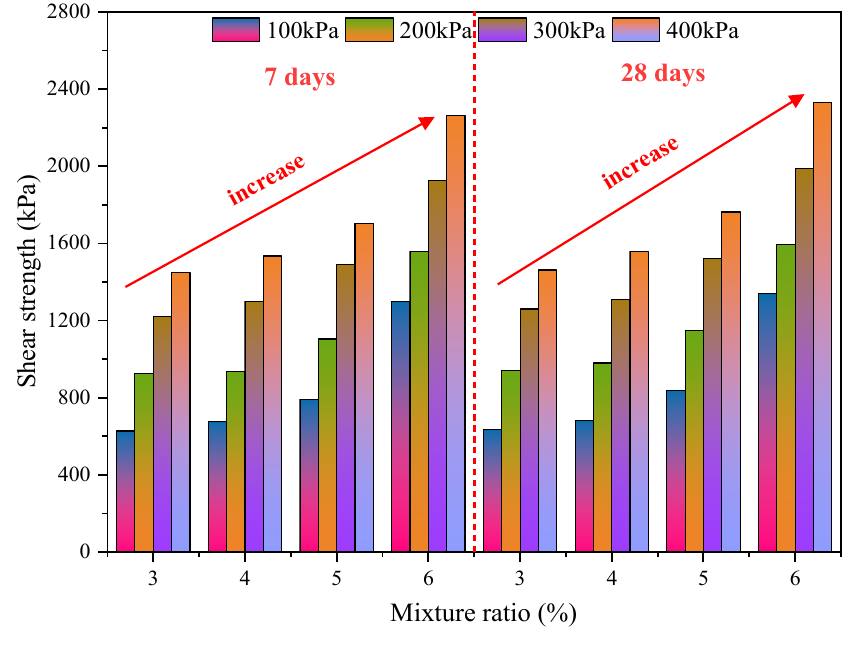
Figure 7. Shear Figure 7. Shear strength.